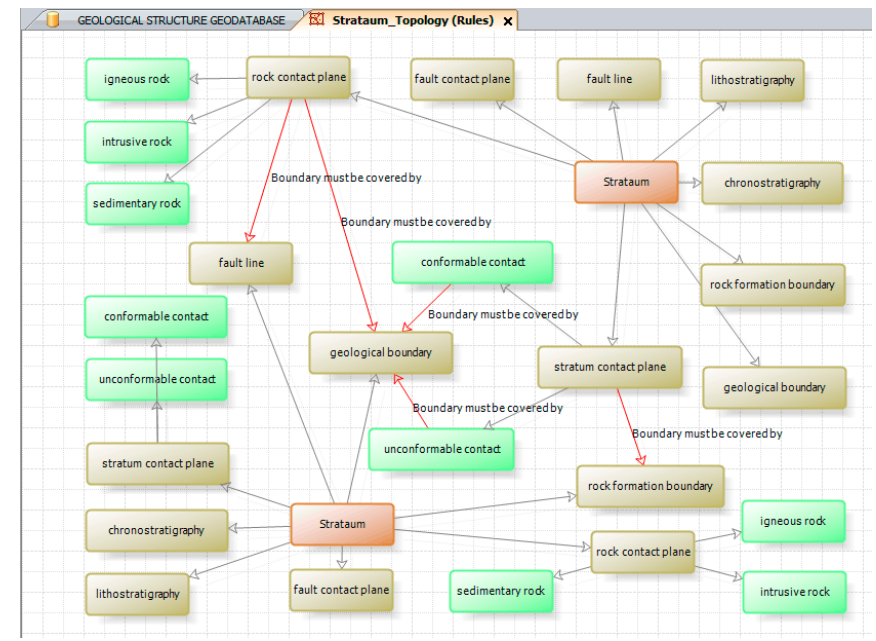
Figure 4. Geodatabase data model of the topology of stratum elements.